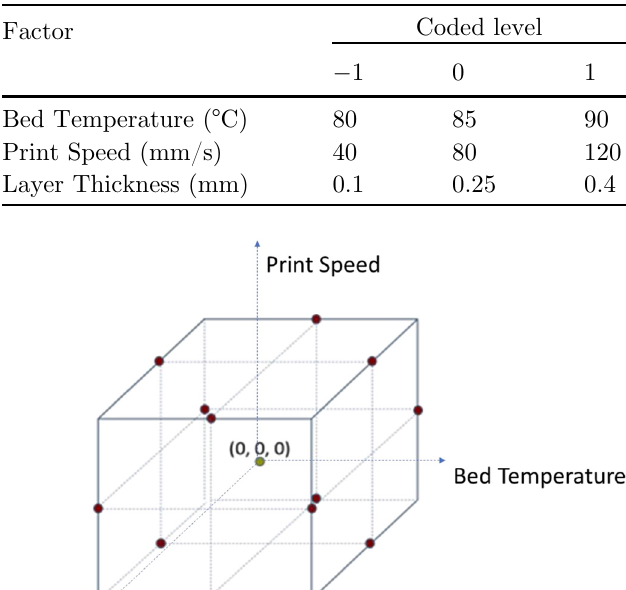
Table 1. Input factors and their levels.